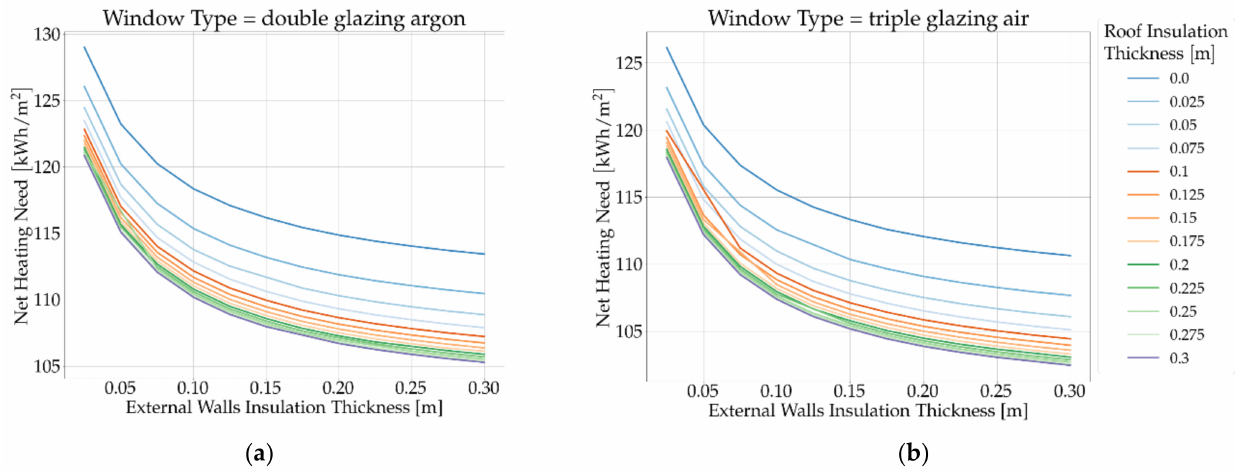
Figure 4. Retrieved simulation results plotting net energy needed for different wall and roof insulation thicknesses—that is, substituting current windows ( a ) with a double gazing with argon, or ( b ) triple glazing with